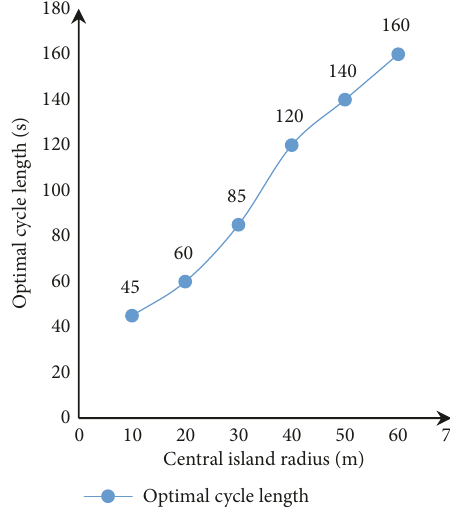
Figure 7: The optimal cycle length of